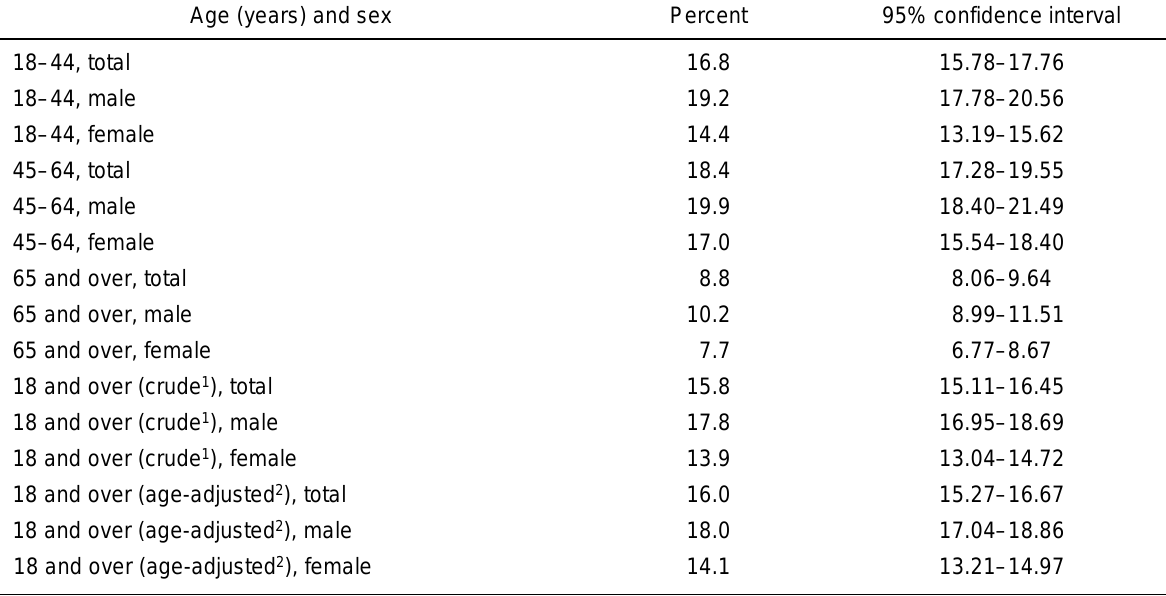
Data table for Figure 8.3. Prevalence of current cigarette smoking among adults aged 18 and over, by age group and sex: United States,